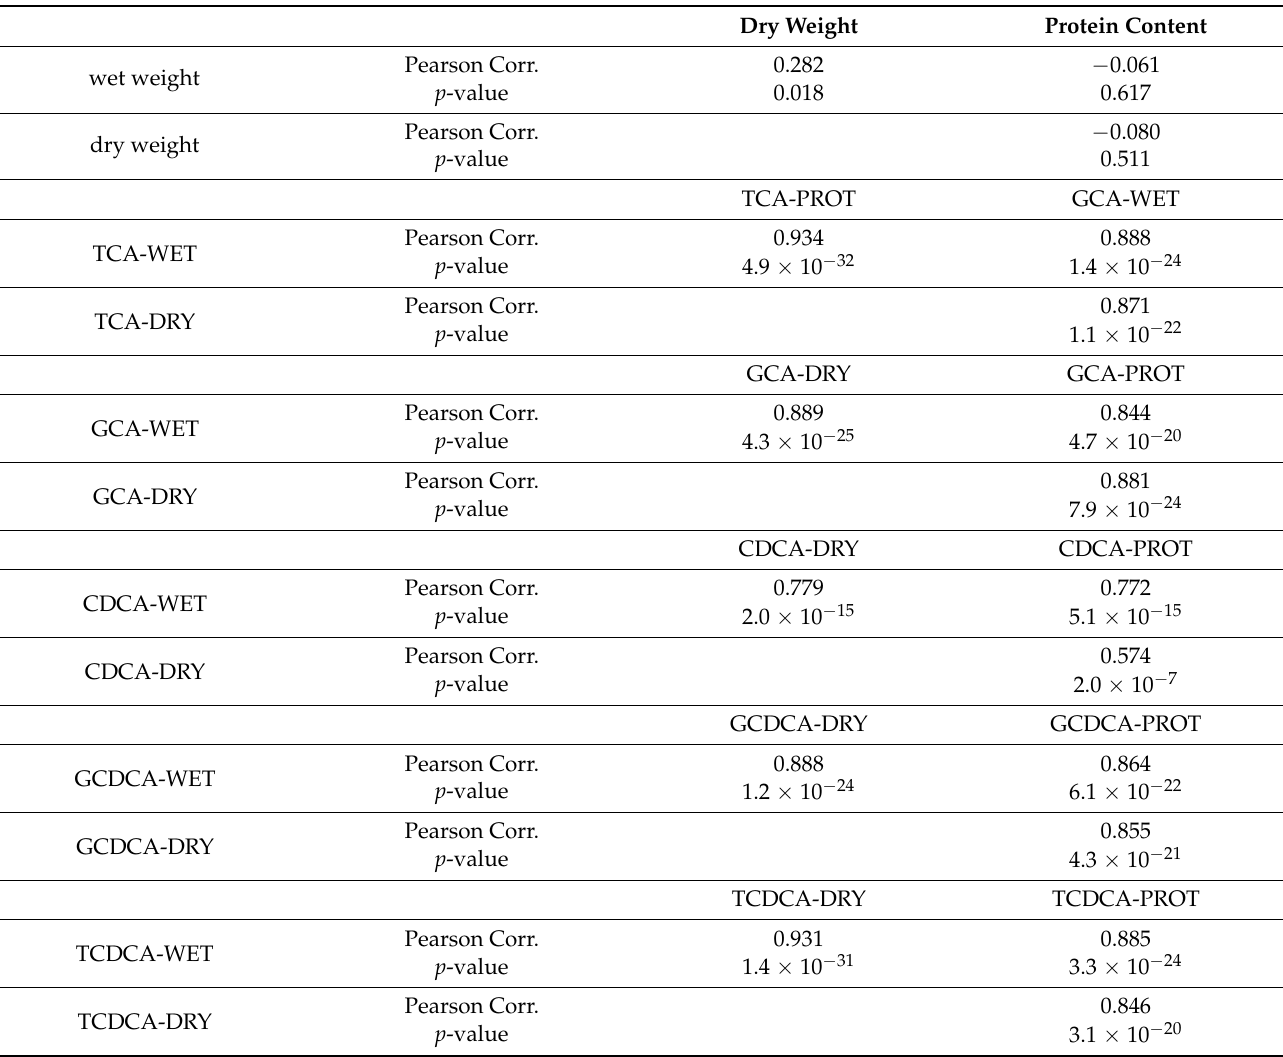
Table 2. Coefficient of determination (R 2) for the Pearson correlations of fecal taurocholic acid (TCA), glycocholic acid (GCA), chenodeoxycholic acid (CDCA), glycochenodeoxycholic acid (GCDCA) normalized by wet weight (WET), dry weight (DRY), and protein content (PROT). Dry Weight Protein Content Pearson Corr. 0.282